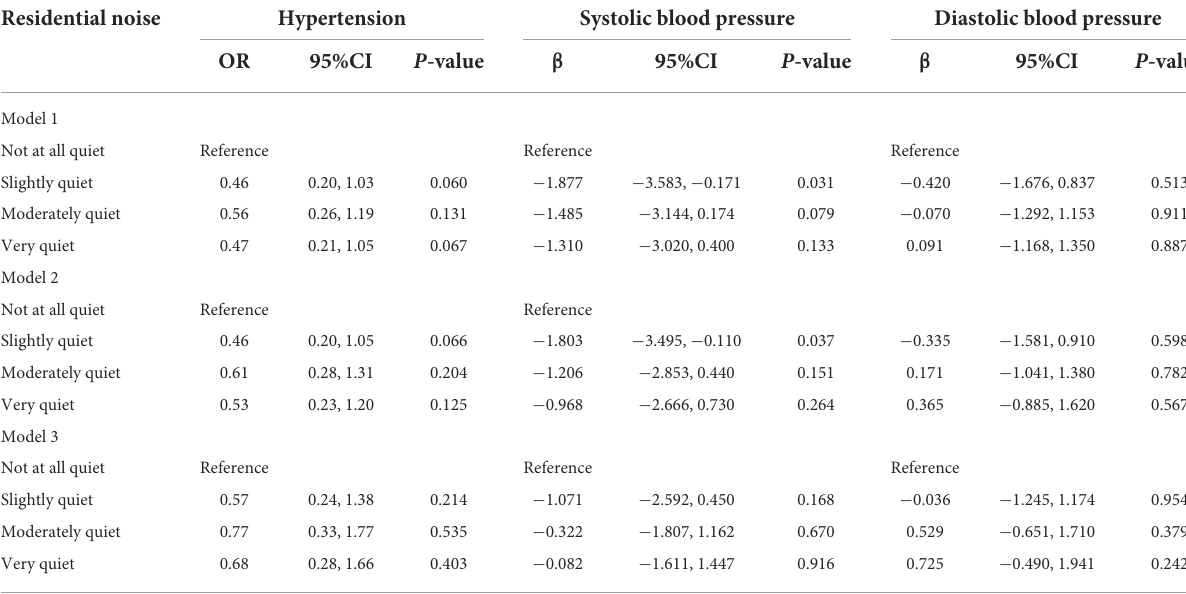
TABLE 4 Associations of self–reported noise exposure with hypertension and blood